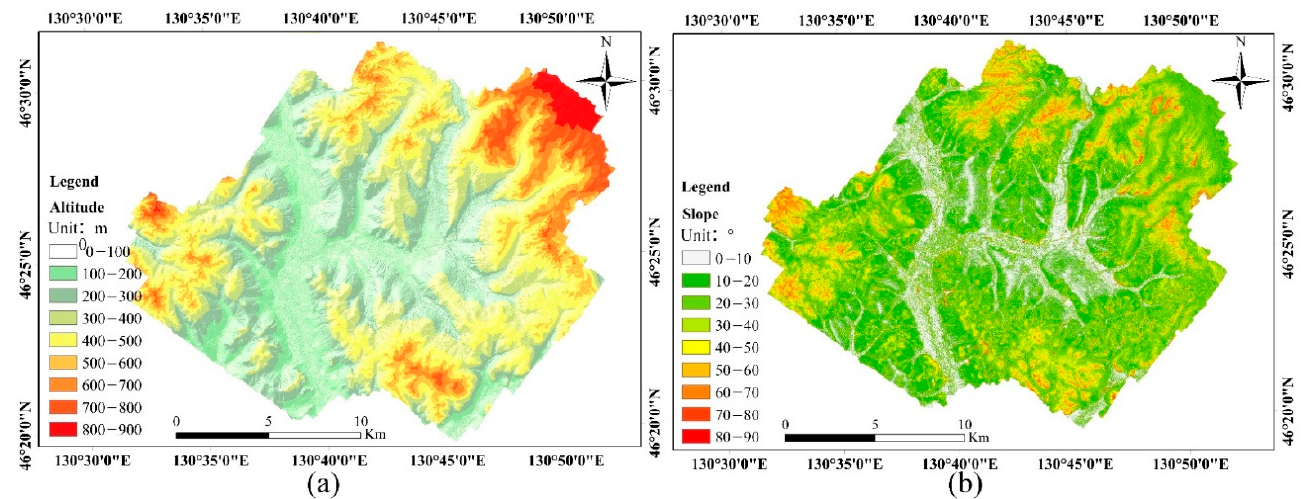
Figure 2. Distribution of altitude ( a ) and slope ( b ) in Mengjiagang forest area, extracted based on DEM data and GIS spatial analysis.